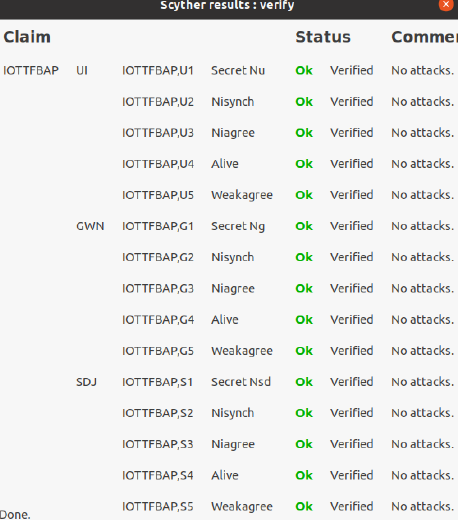
Figure 6. Scyther tool simulation result of